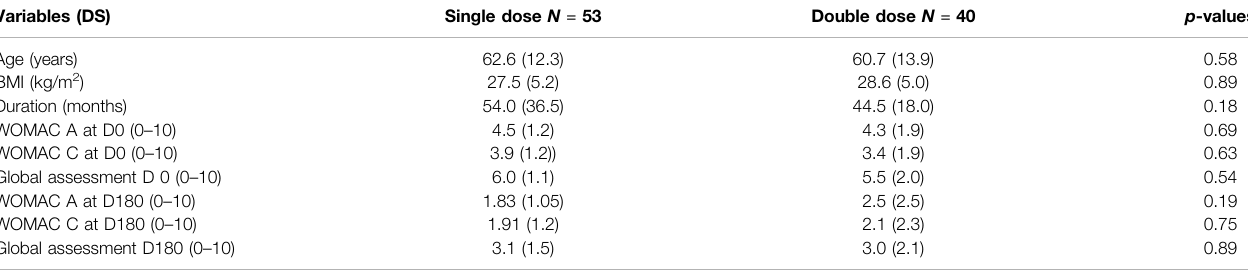
TABLE1| Characteristicsofpatients(N=93)treatedwithasingle-dose(N=53)oradouble-dose(N=40)ofHANOX-M-XL(HAPPYCROSS ® )forpainfulkneeosteoarthritis. Variables